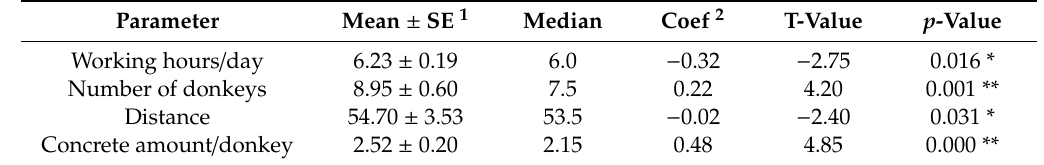
Table 6. Numerical summary of the environmental parameters (median and mean ± standard error), and the coe ffi cient values, t-values, and p -values of the multiple linear